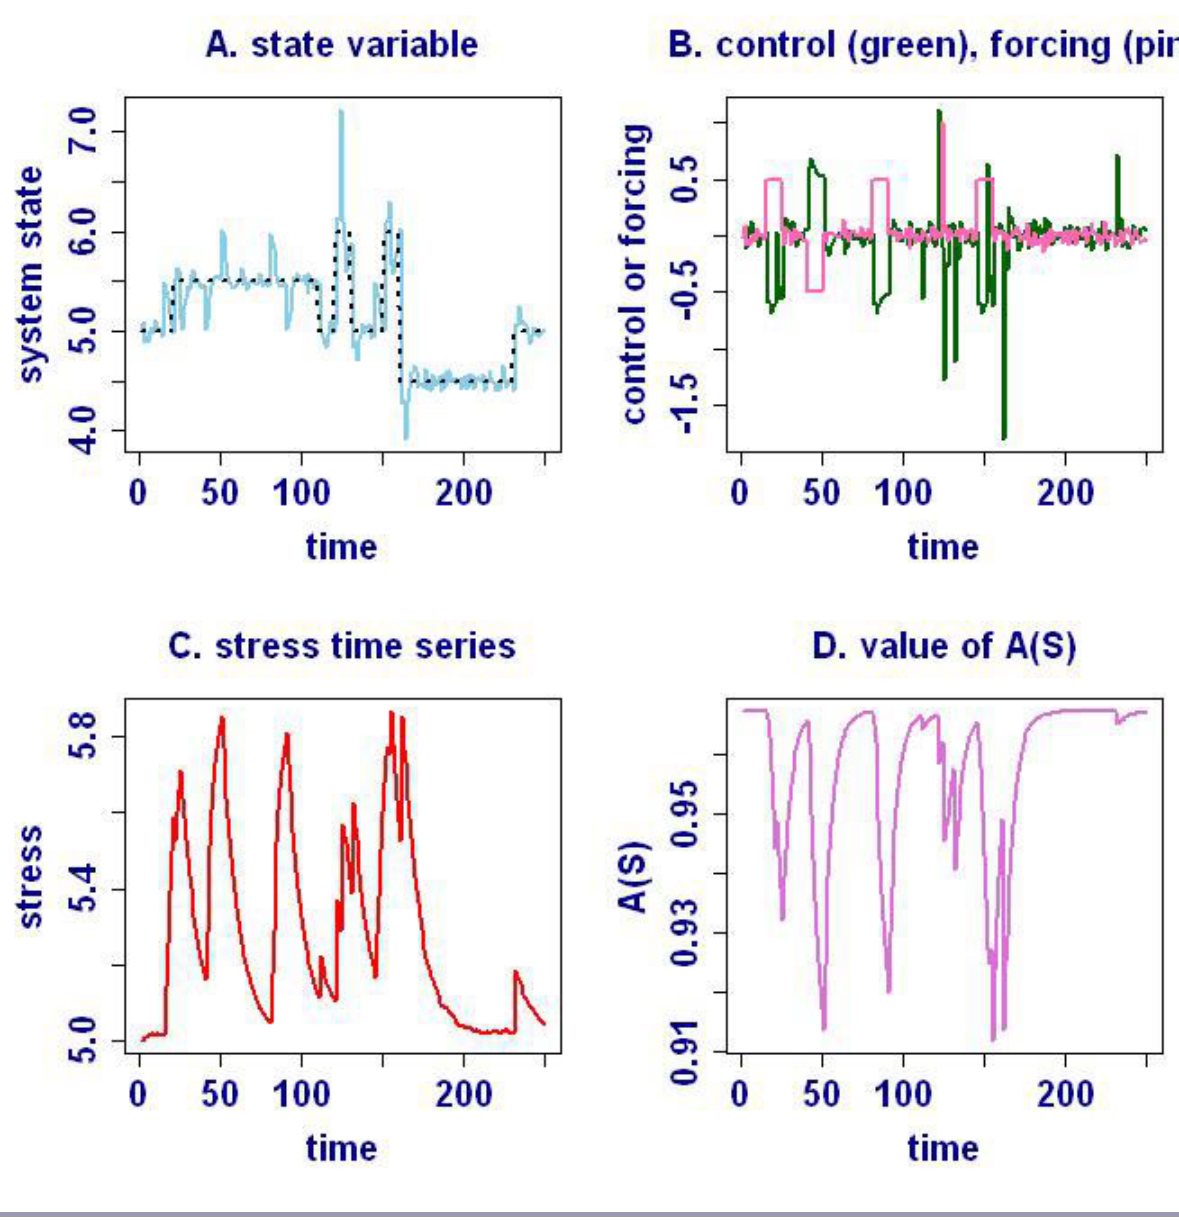
Fig. 2. Example of dynamics with stress levels in the adaptive range (S* = 5). (A) State variable y (light blue) and target y* (dark blue dash). Standard deviation of the distance of y from the target is 0.24. (B) Control magnitude u and disturbance n. (C) Stress S. (D) Adaptive capacity